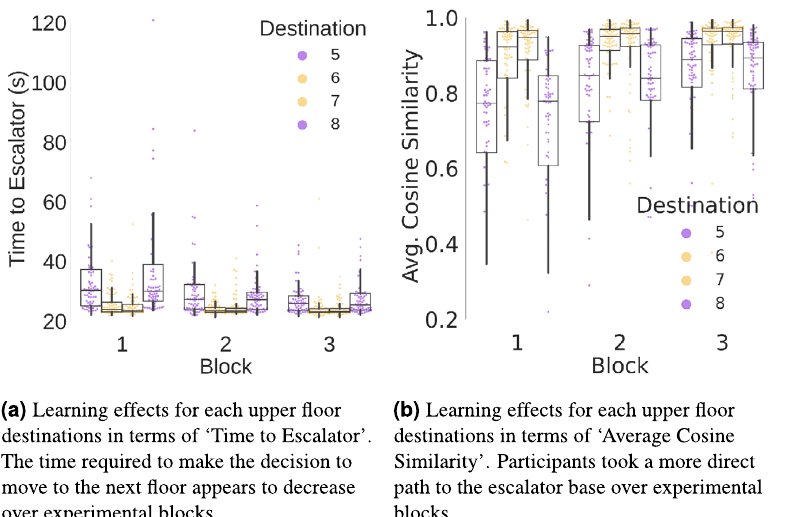
Figure 4. Learning effects over blocks of trials. Software used to create these figure: Python 34 (version 3.5.8), https:// www. python. org/ downl oads/ relea se/ python- 358/; Seaborn 35 (version 0.11.1), https:// seabo rn. pydata.